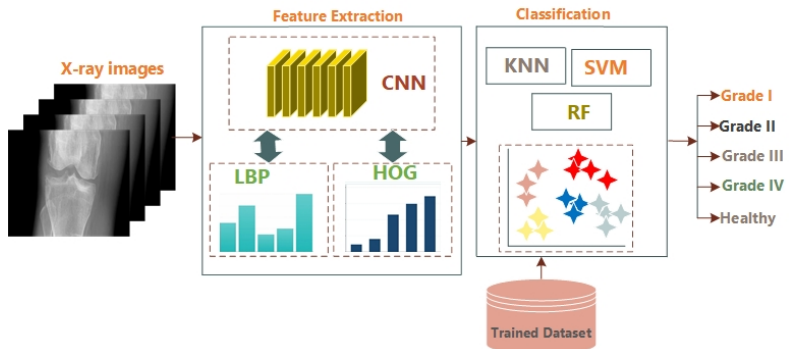
Figure 3. Block Diagram of the Proposed Algorithm.